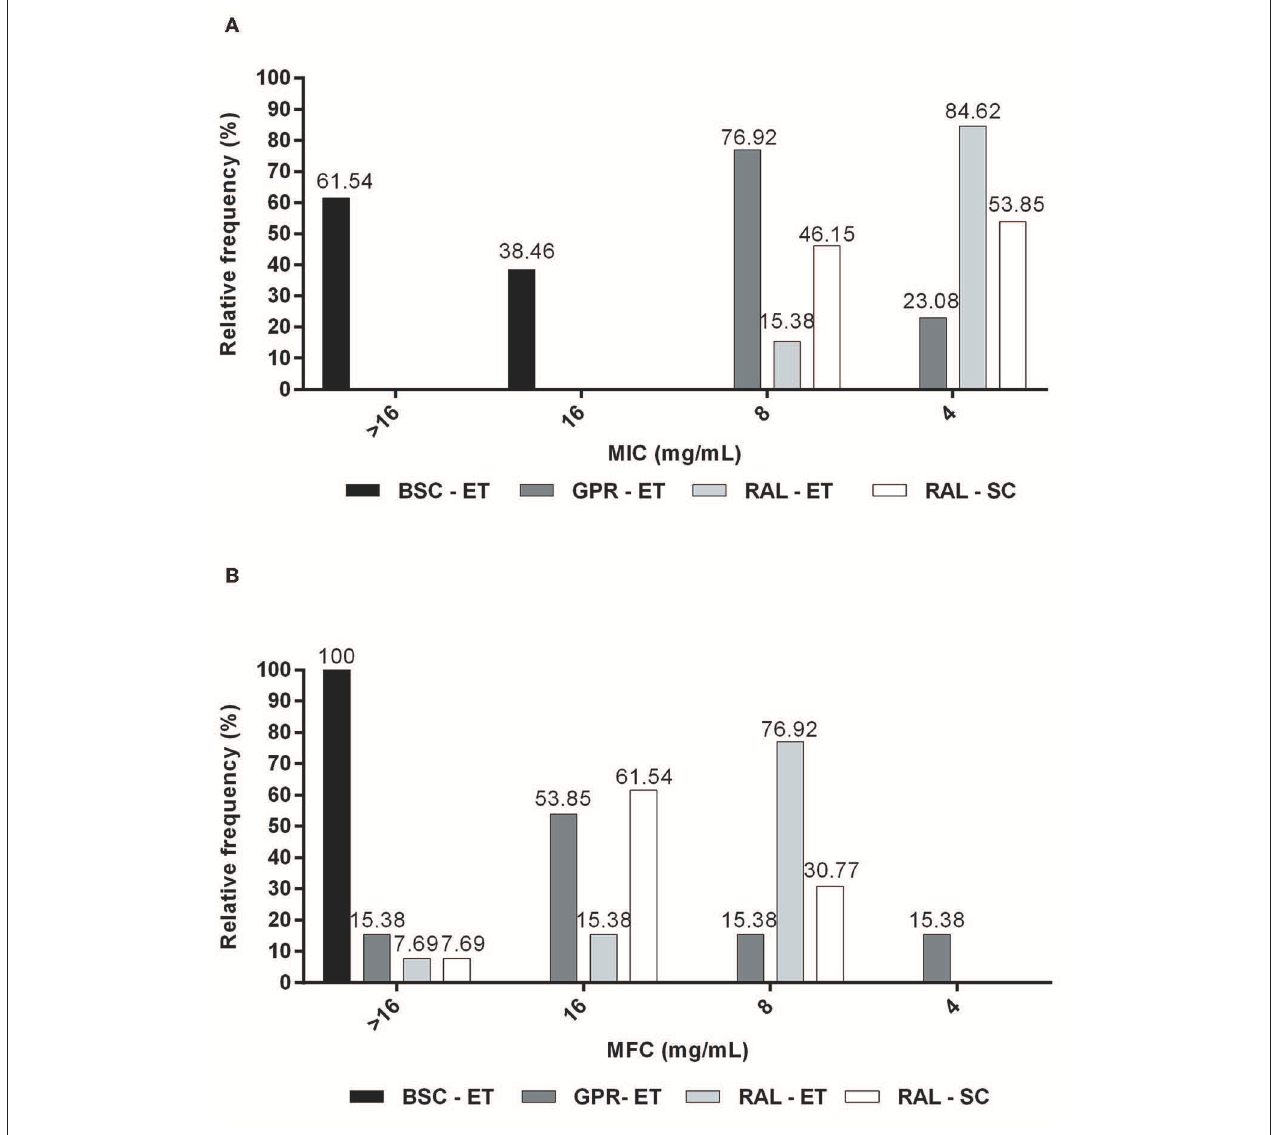
FIGURE 2 | Relative frequency of (A) MIC (mg/mL) and (B) MFC (mg/mL) values obtained from M. pachydermatis isolates against propolis